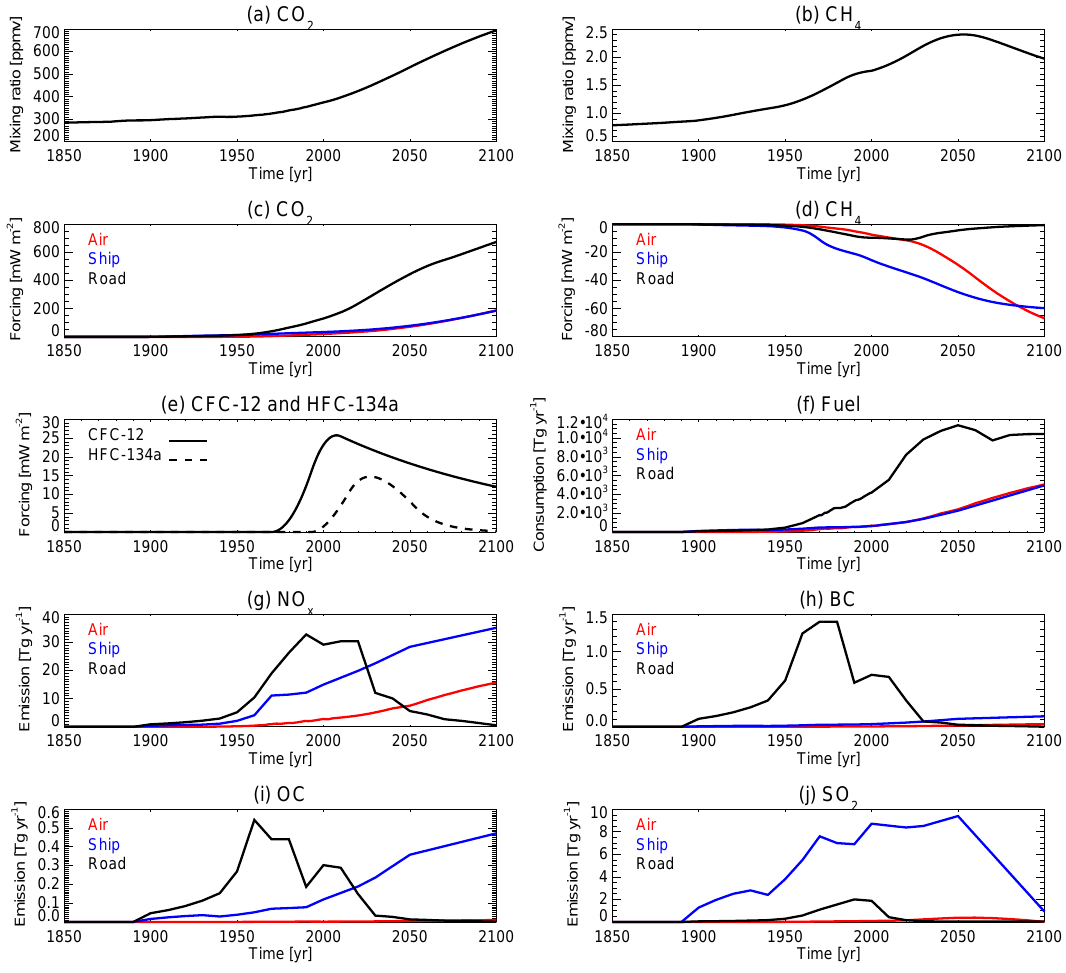
Fig. 1. Time series of the forcings taken into account in the model integrations over the period 1860–2100. The first row shows the evolution of (a) CO 2 and (b) CH 4 mixing ratios in the reference simulation. Row 2 until 5 show forcings and emissions from the transport sectors: (c) radiative forcing from CO 2 , (d) radiative forcing from CH 4 , (e) radiative forcing from CFC-12 and HFC-134a from road transport, (f) global annual fuel consumption, and emissions from (g) NO x , (h) BC, (i) OC and (j) SO 2 .